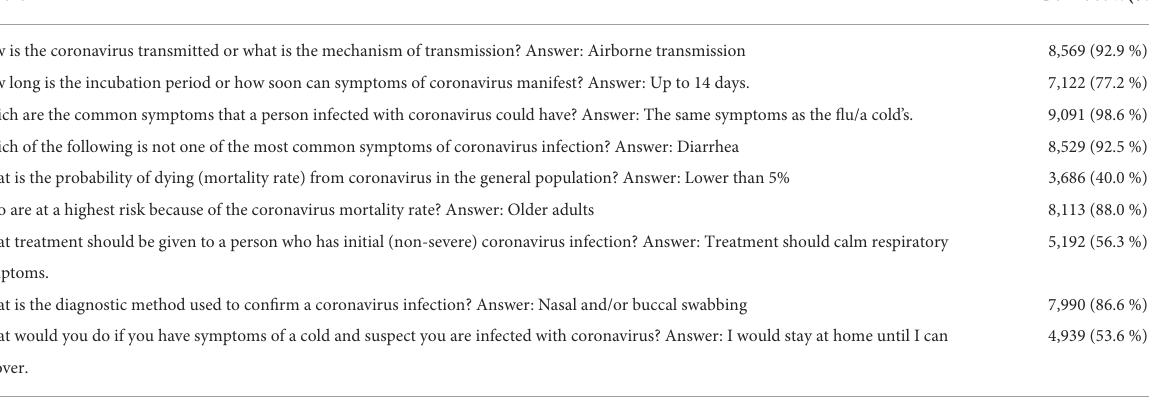
TABLE 1 Percentage of correct answers by each one of the nine questions of basic knowledge of COVID-19 in 12 countries in Latin America. Question